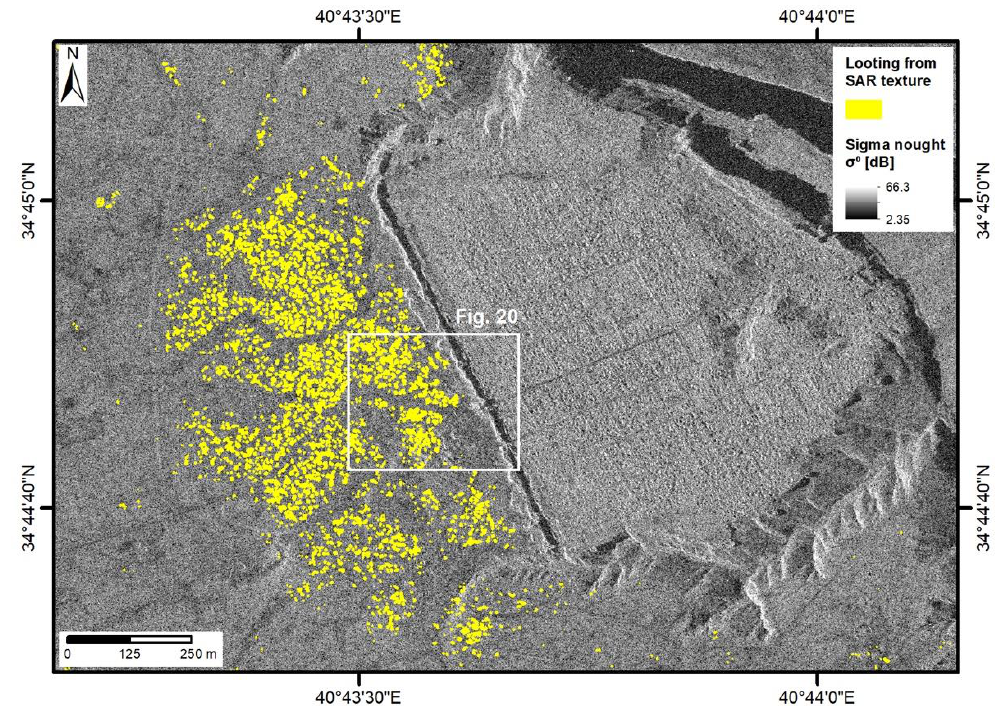
Figure 14. Polygons of extensive and dense looting beyond the walls of Dura Europos (Syria) extracted from the SAR texture map of the COSMO-SkyMed Enhanced Spotlight (~1 m ground resolution) image acquired in ascending mode on 11/01/2019, that is displayed on the background (COSMO-SkyMed ® Product © ASI—Italian Space Agency—2019. All Rights Reserved). The inset shows the location of Figure 20.